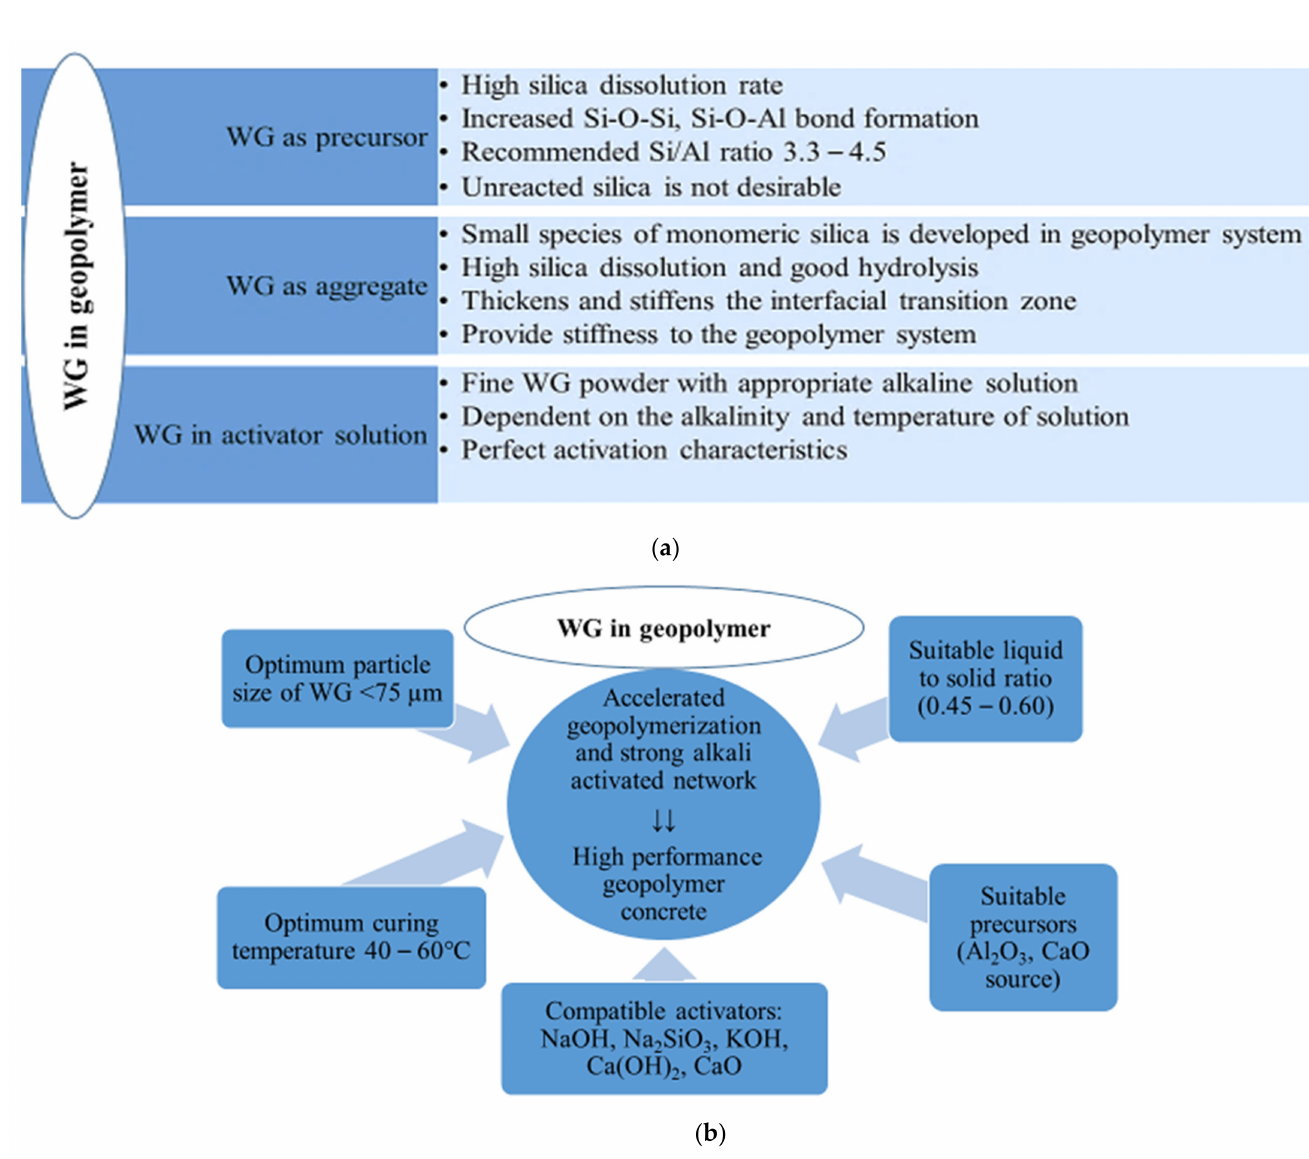
Figure 24. Different roles of WG and the impacts of different parameters on the performance of geopolymer concrete [4]. ( a ) Reactivity and roles of WG in geopolymer concrete; ( b ) Crucial process parameters in alkali activation and geopolymer- ization with